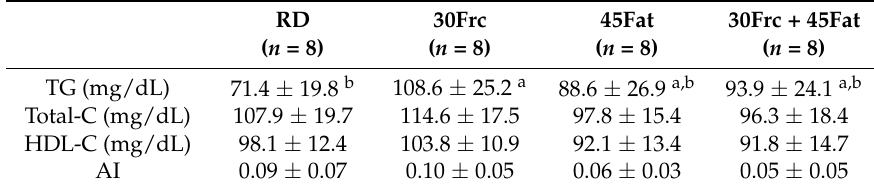
Table 4. Serum levels of lipid profiles.